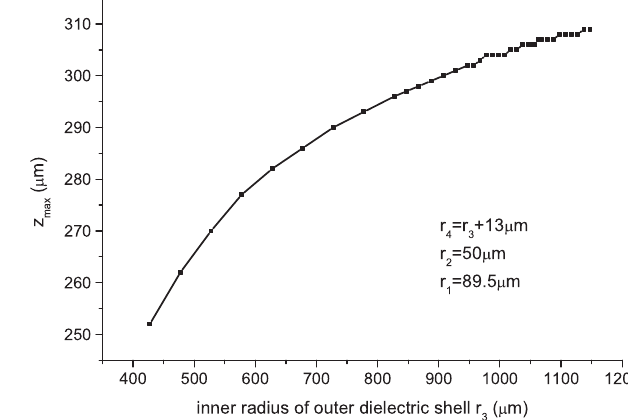
FIG. 6. (Color) The value of the composite longitudinal electric field at the first axial maximum and corresponding transformer ratio versus the dimension of the drive channel. The thickness of the outer dielectric shell is fixed and equal 13 (cid:1) m . The other parameters are the same as those in Table